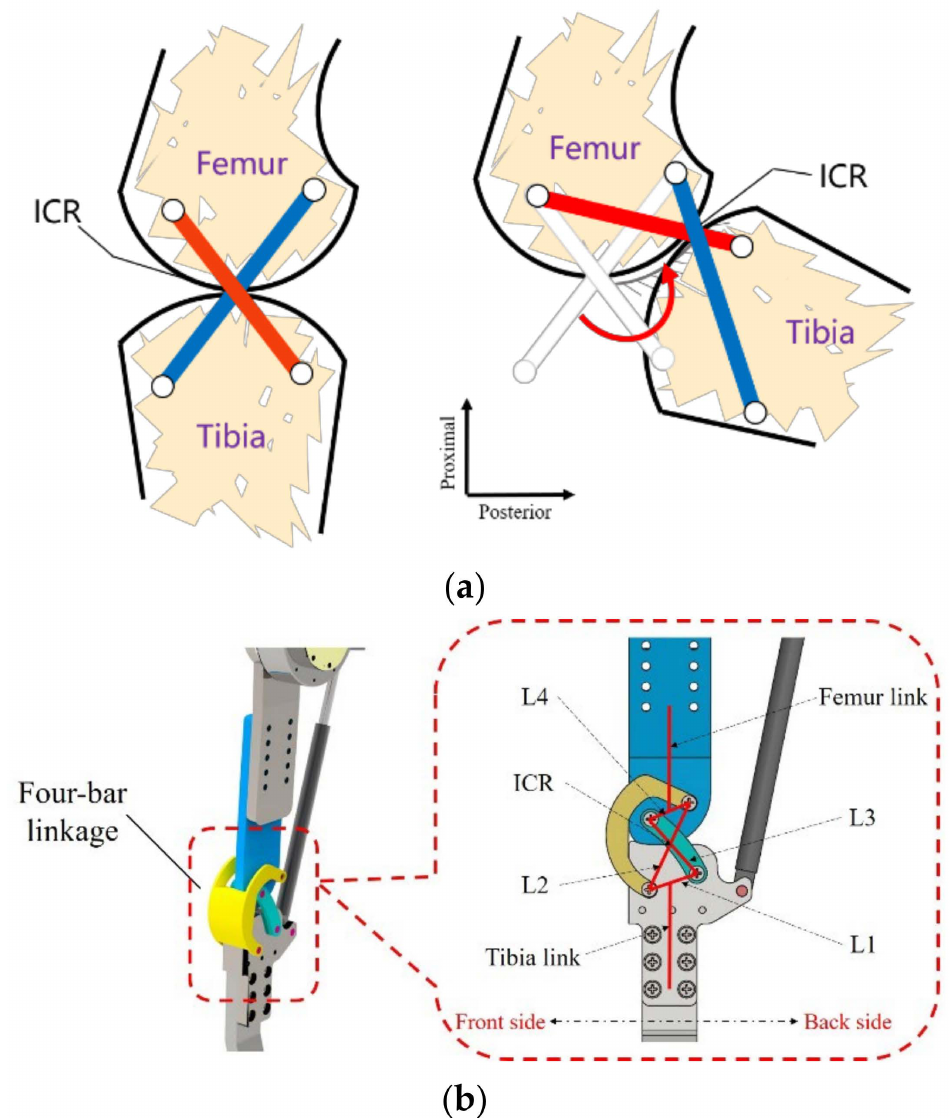
Figure 10. Crossed four-bar linkage knee exoskeleton structure: ( a ) Simple model of knee exoskeleton structure; ( b ) Analytic diagram of knee exoskeleton